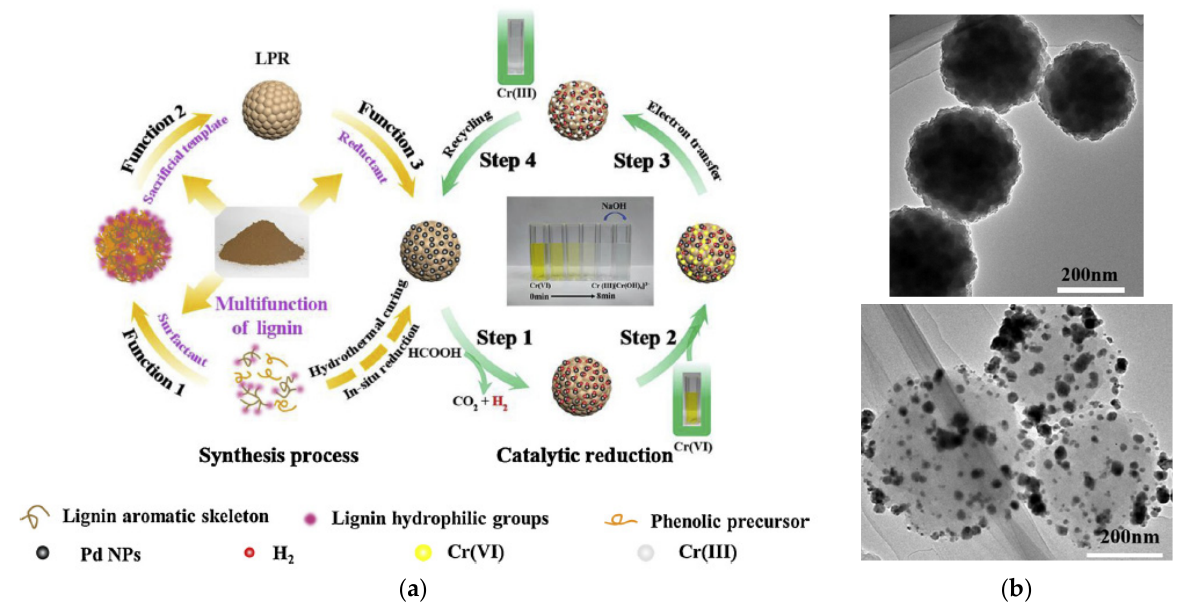
Figure 26. ( a ) Preparation of the catalyst supported on lignin-based phenolic resin (LPR) and reac- tion mechanism for the reduction of Cr(VI); ( b ) TEM images of LPR nanospheres ( top ) and